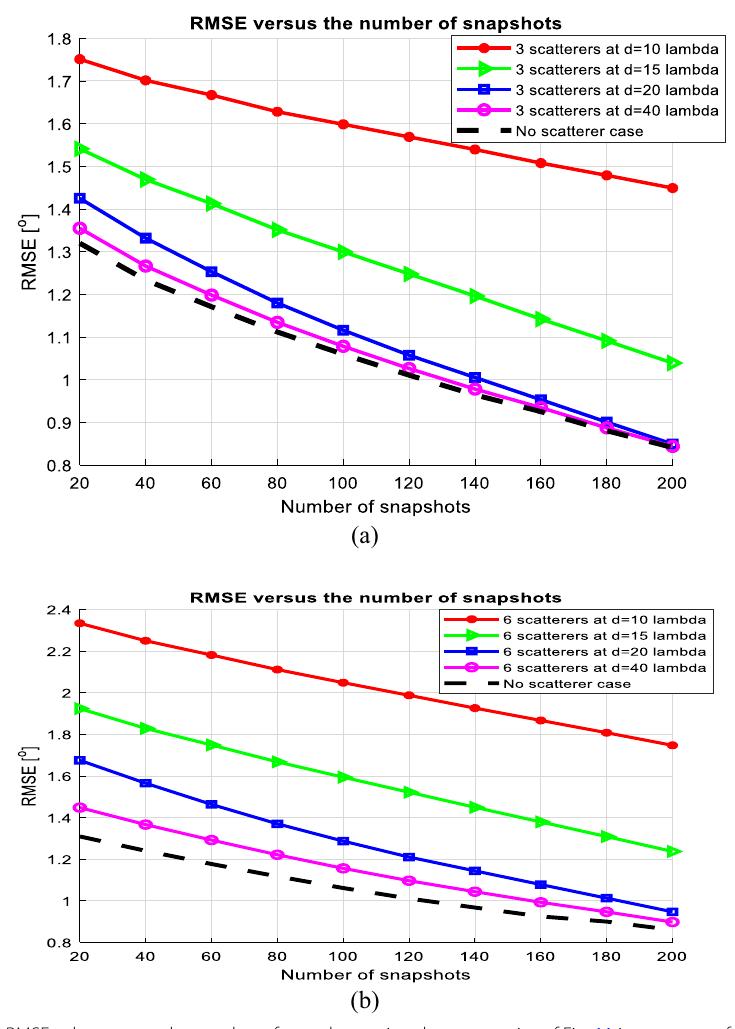
Fig. 12 RMSE values versus the number of snapshots using the geometries of Fig. 11 in presence of scatterers at d = 10 (cid:31) ,15 (cid:31) ,20 (cid:31) ,40 (cid:31) distances compared to no scatterer case, at fixed SNR cylindrical scatterers, b six large cylindrical